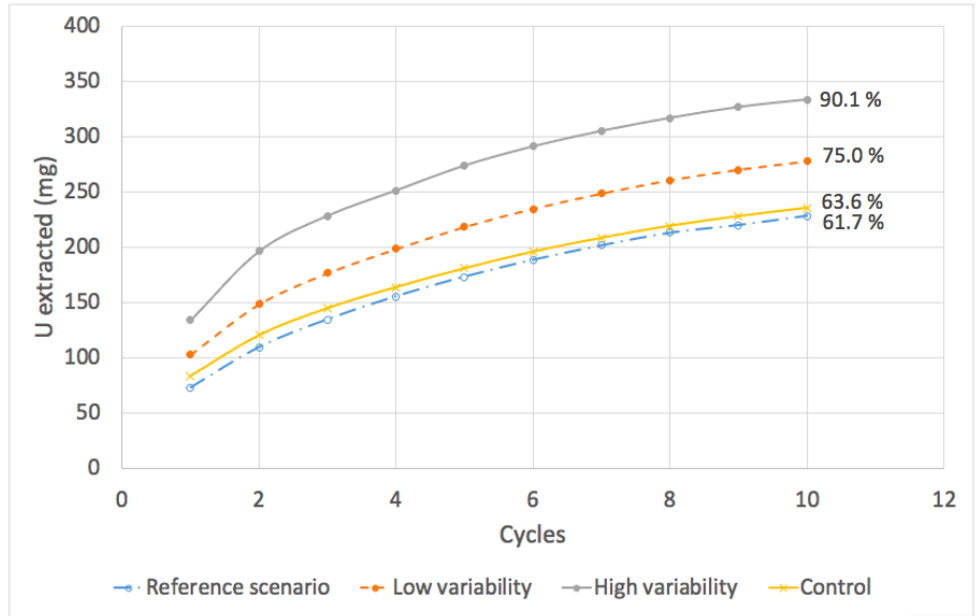
Figure 7. Cumulated mass of U collected in the leachate for each tested scenario. For the reference, low variability and high variability scenarios, results correspond to the average cumulated masses of the duplicates. Next to each curve is indicated the final cumulated mass of U extracted, expressed as percentage of total U in the pristine tailings.